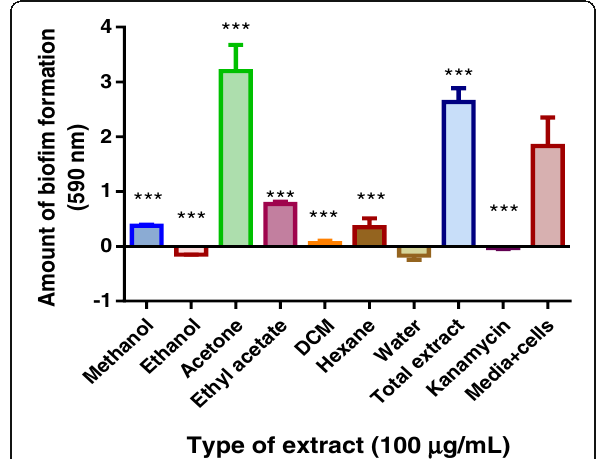
Fig. 5 The effects of 100 μ g/ml of the different P . curatellifolia leaf extracts on M. smegmatis biofilm formation. M. smegmatis was incubated with the plant extracts for 72 h at 37 ̊ C. The biofilm mass that formed during the incubation period was stained using crystal violet. The absorbance values of crystal violet are directly proportional to the amount of biofilm that had formed. The dye was extracted using ethanol and quantified spectrophotometrically at 590